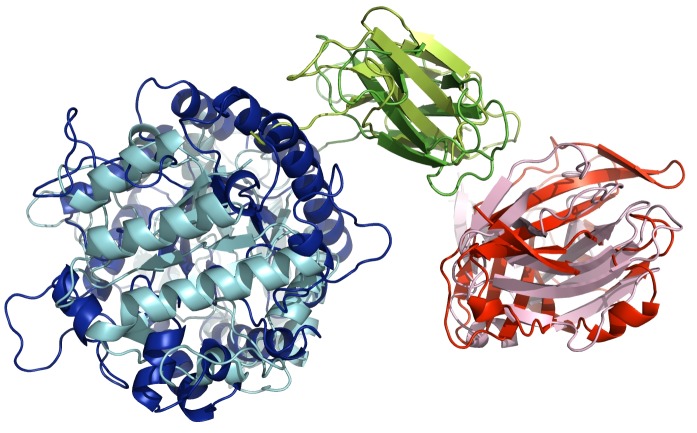
EOM and RBM models.Superposition of the EOM highest frequency model (light blue, light green and pink) and the rigid-body model (RBM) obtained using the CORAL package (dark blue, dark green and red).